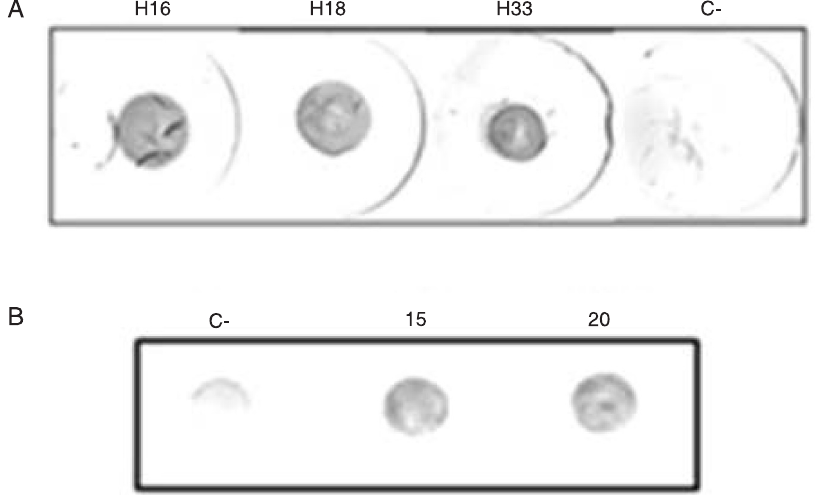
Figure 3. Dot blot for the detection of intracellular and extracellular production of the L1 pro- tein. The samples were standardized to an amount of 0.9 µg, which was applied to a nitrocel- lulose membrane. The specific reactions with the lysates of clones, shown in A by H16, H18 and H33 and in B by clones 15 and 20, confirm the presence of the L1 protein of the three viral types. In contrast, in the lysate and in the supernatant of the negative controls (C-) there were no